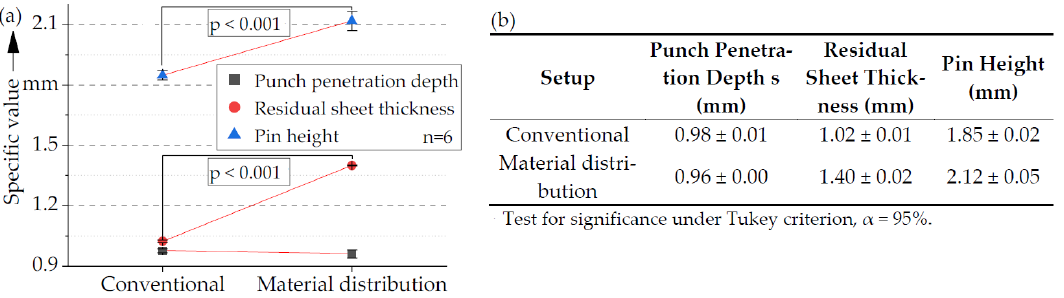
Figure 8. ( a ) Graphical and ( b ) calculated comparison of the relevant geometric properties of the conventional and orbital formed samples measured after pin